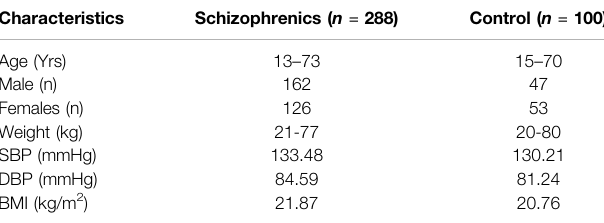
TABLE 1 | Demographic/physical